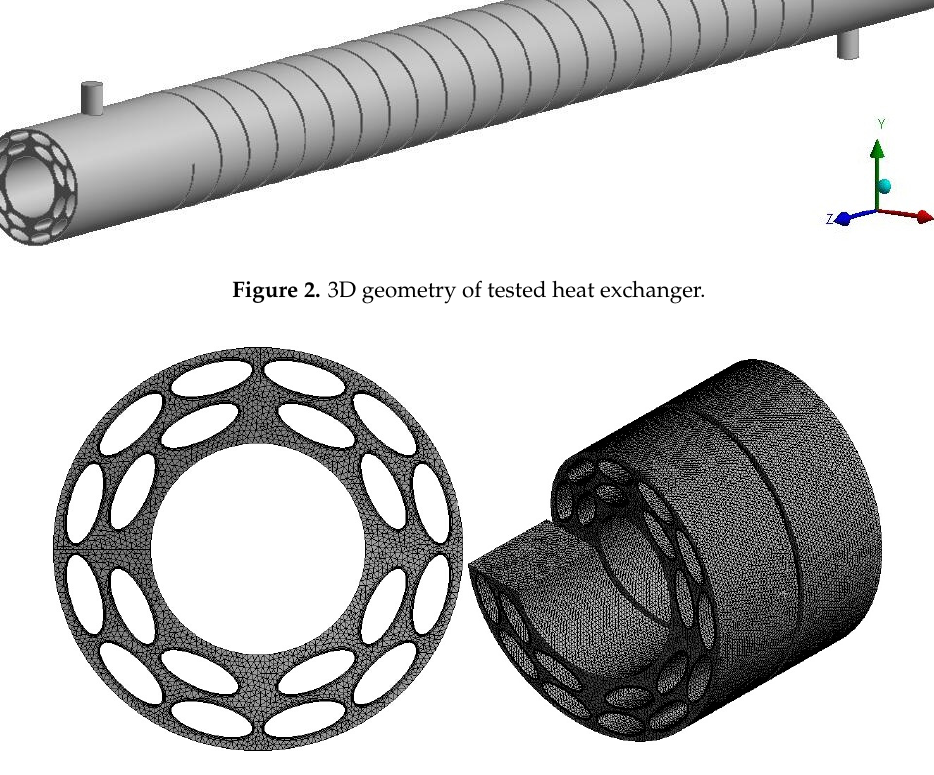
Figure 3. Meshes of numerical models.